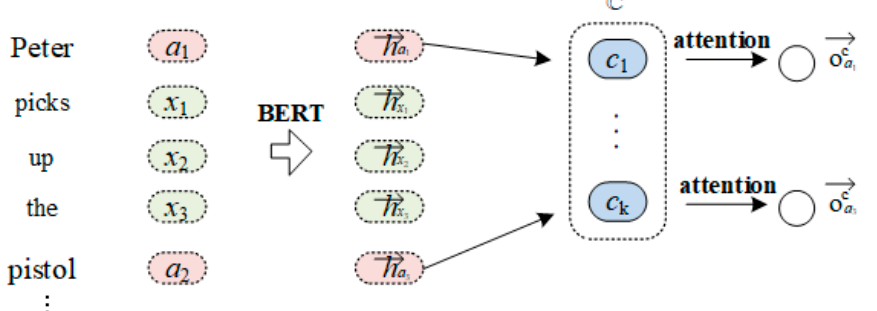
Figure 2. Framework of attentive high-level role modules.